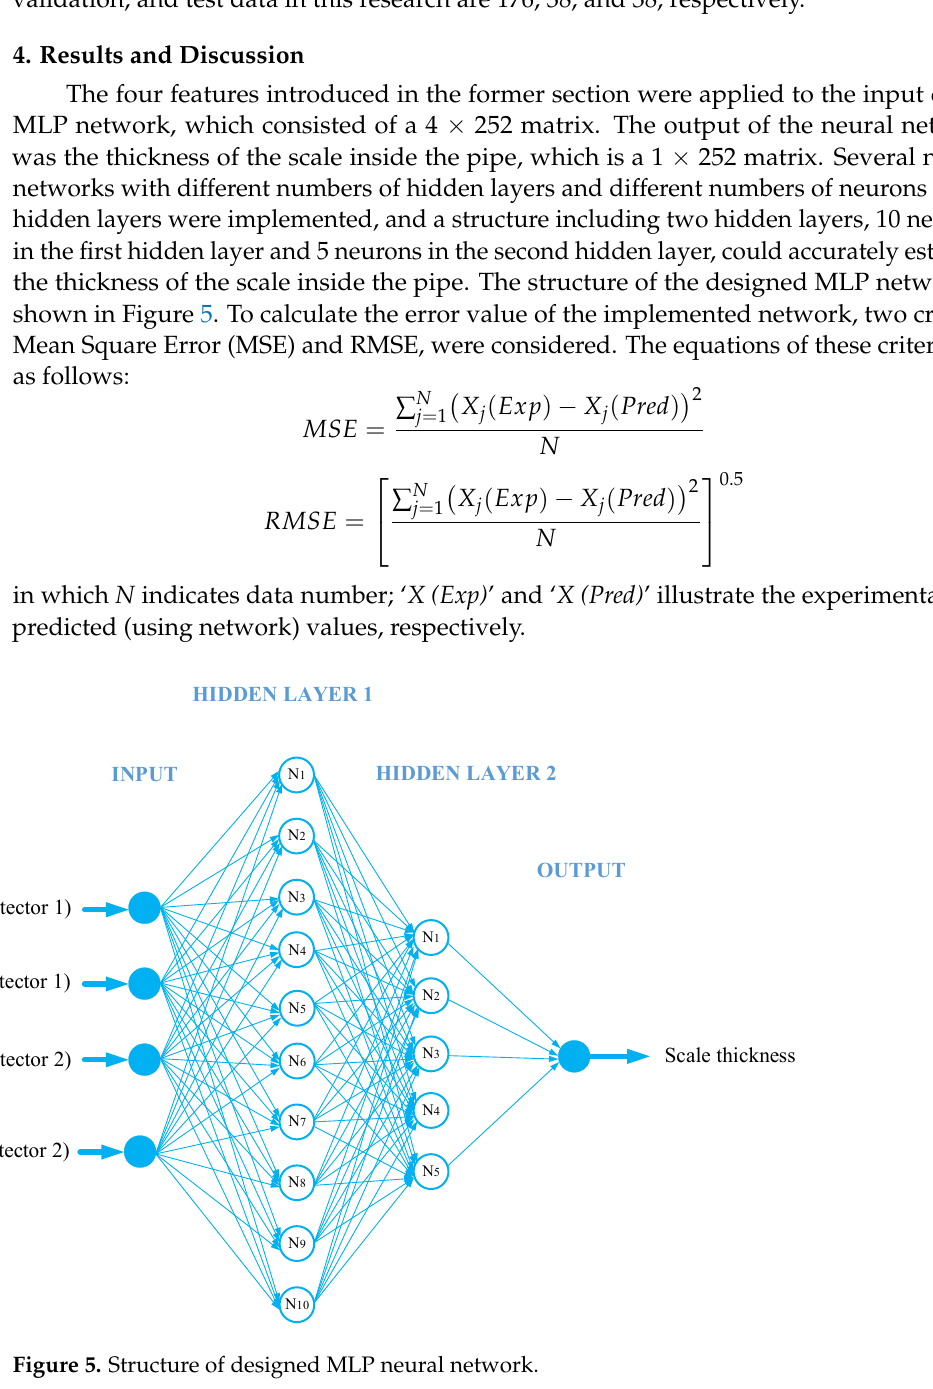
dashed line and the network output is shown with a black line. In the second diagram, the desired output is visible as a red dashed line, and the outputs of the neural network is visible as black squares. This diagram is presented as a regression diagram. The horizontal axis in this diagram shows the data number, and the vertical axis shows the thickness of the scale. The histogram diagram shows the value of error distribution; the distribution of